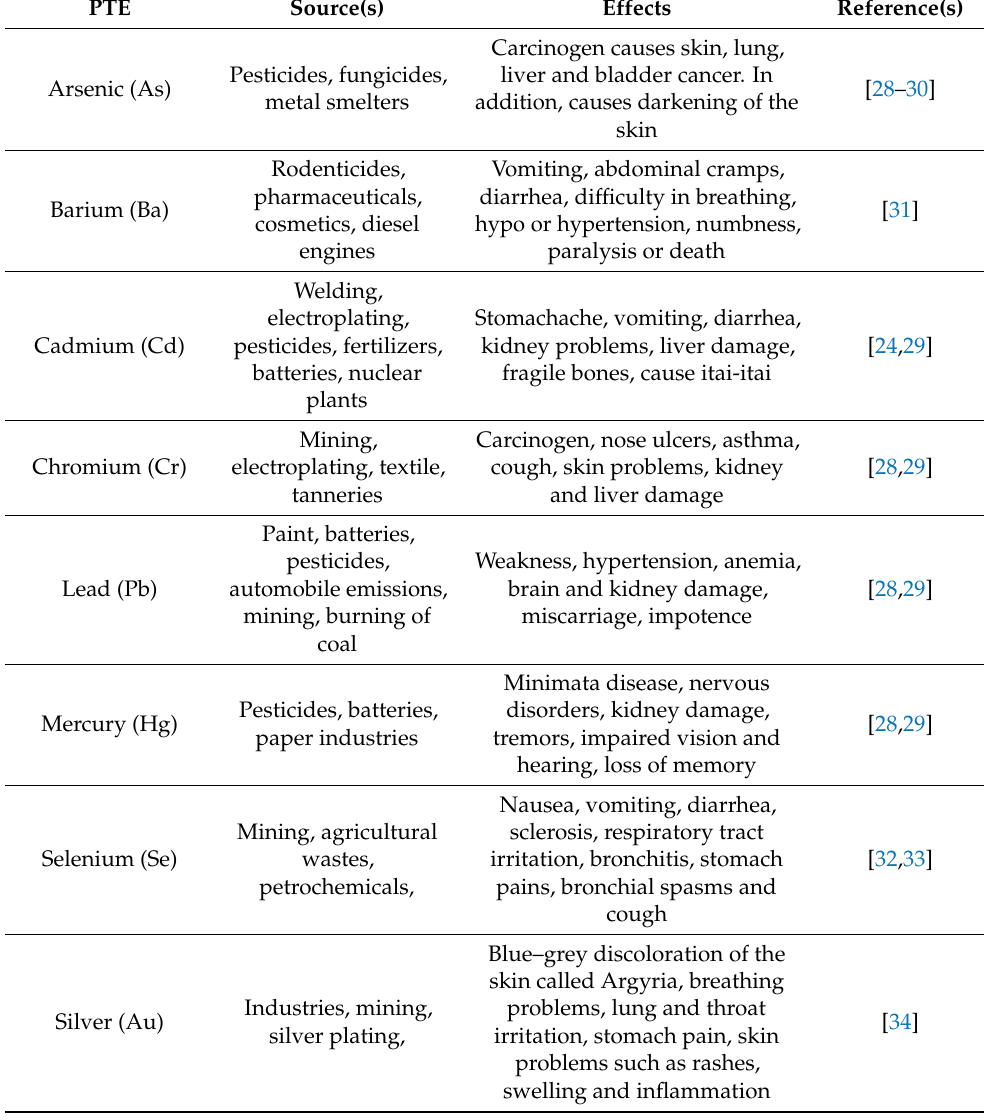
Table 1. Sources and effects of the major PTEs on human